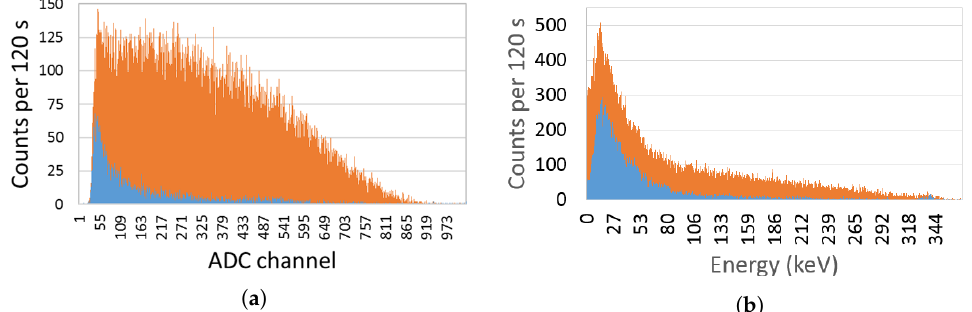
Figure 13. Beta spectra of a 3.3 kBq 90 Sr source next to the detector window (orange color) and background (blue color) obtained with the: ( a ) EJ-200 scintillator (total counts: 61,561 ± 248; background counts: 5308 ± 73). ( b ) CsI(Tl) scintillator (total counts: 50,999 ± 226; background counts: 17,536 ±